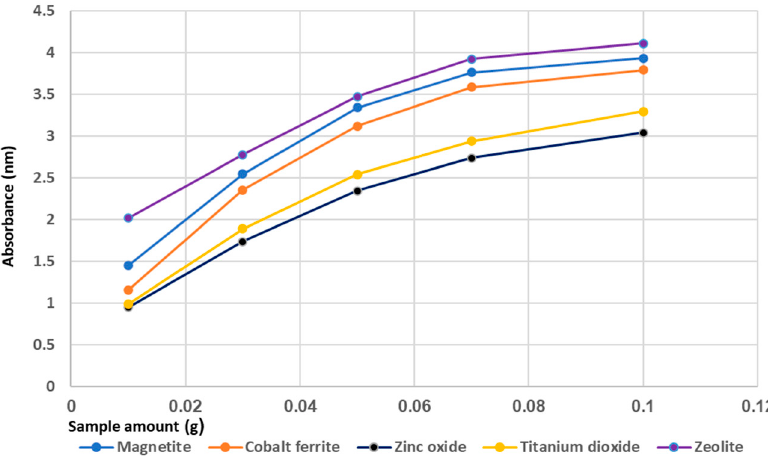
Figure 9. Comparison of different adsorbents used for phosphorus